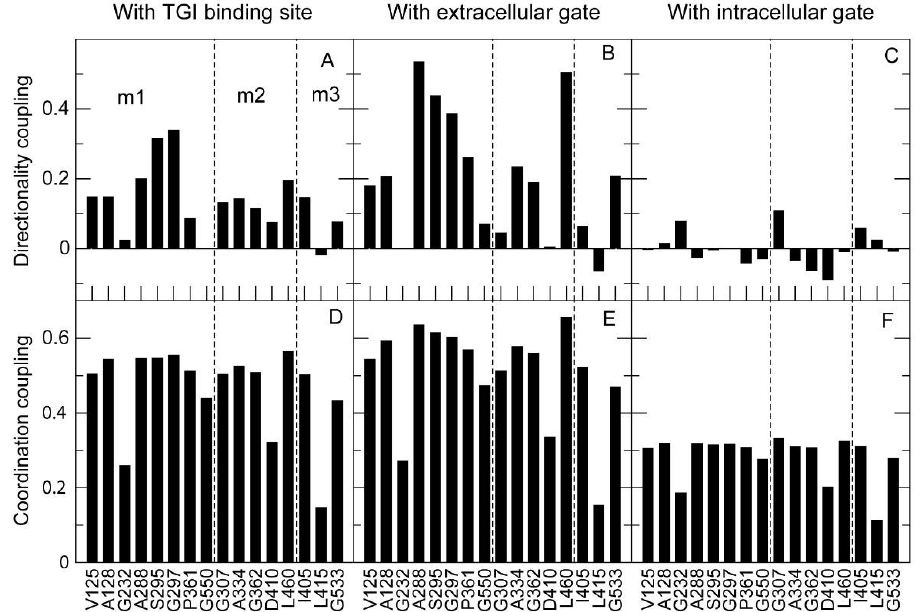
Figure 9. Directionality coupling ( A – C ) and coordination coupling ( D – F ) between the 16 mutated sites (horizontal axis) and three functional sites of GAT-1: the tiagabine binding site (TGI) (first column, A , D ), the extracellular gate (second column, B , E ) and the intracellular gate (third column, C , F ). Mutants are shown in three groups separated by dashed lines: pathogenic mutants that prejudice transport to the membrane (m1); pathogenic mutants that do not prejudice transport to the membrane (m2); and non-pathogenic mutants (m3). Note that most sites are positively co-directional and strongly coordinated with the tiagabine binding site, which is thought to overlap the GABA binding site.